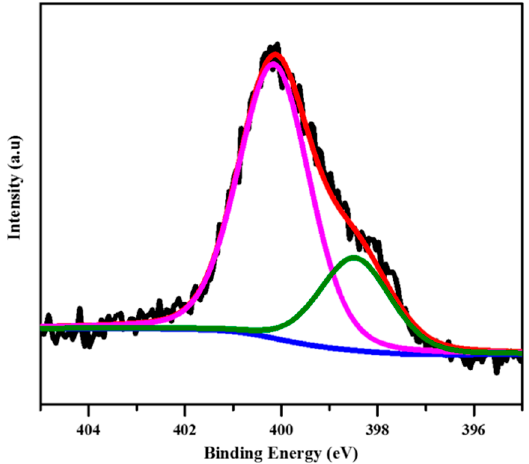
Figure 6. XPS spectra of N1s. There are two peaks with BEs at 400.1 and 398.4 eV, which were attributed to the –NH on the pyrrole nitrogen and the O–H…N=C of the imine nitrogen with hydrogen bonding (purple curve), and the imine nitrogen in the porphyrin unit (green curve), background (blue curve), fitting curve (red curve).